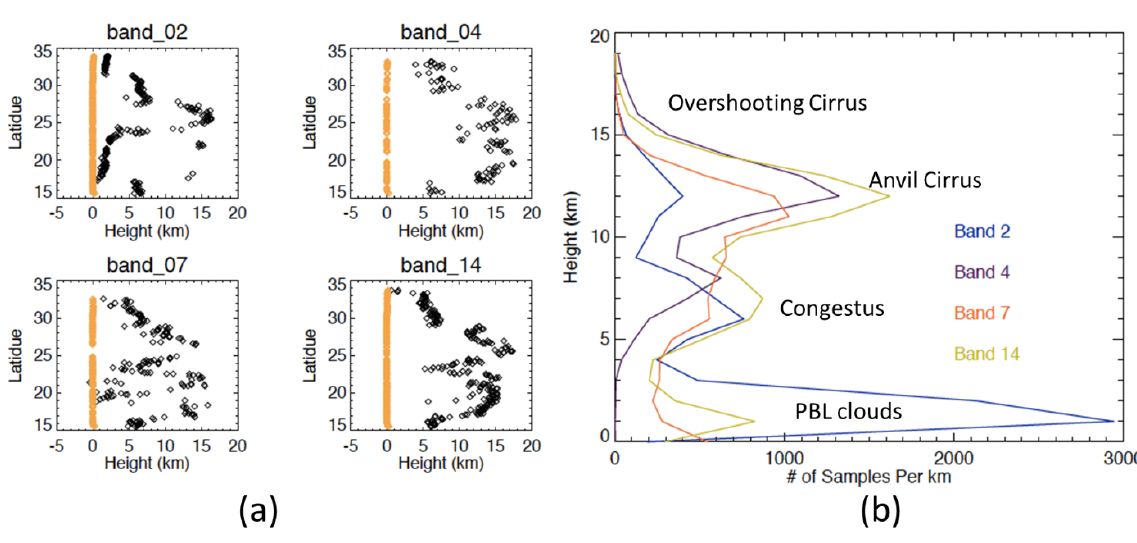
Figure 30. ( a ) Stereo height retrievals along 87.5 ◦ W longitude for the four spectral bands. The surface height is in orange. ( b ) Vertical distributions of the AMV stereo heights derived from the four spectral bands for the entire granule. All height retrievals are from chip size 32 × 32 km.